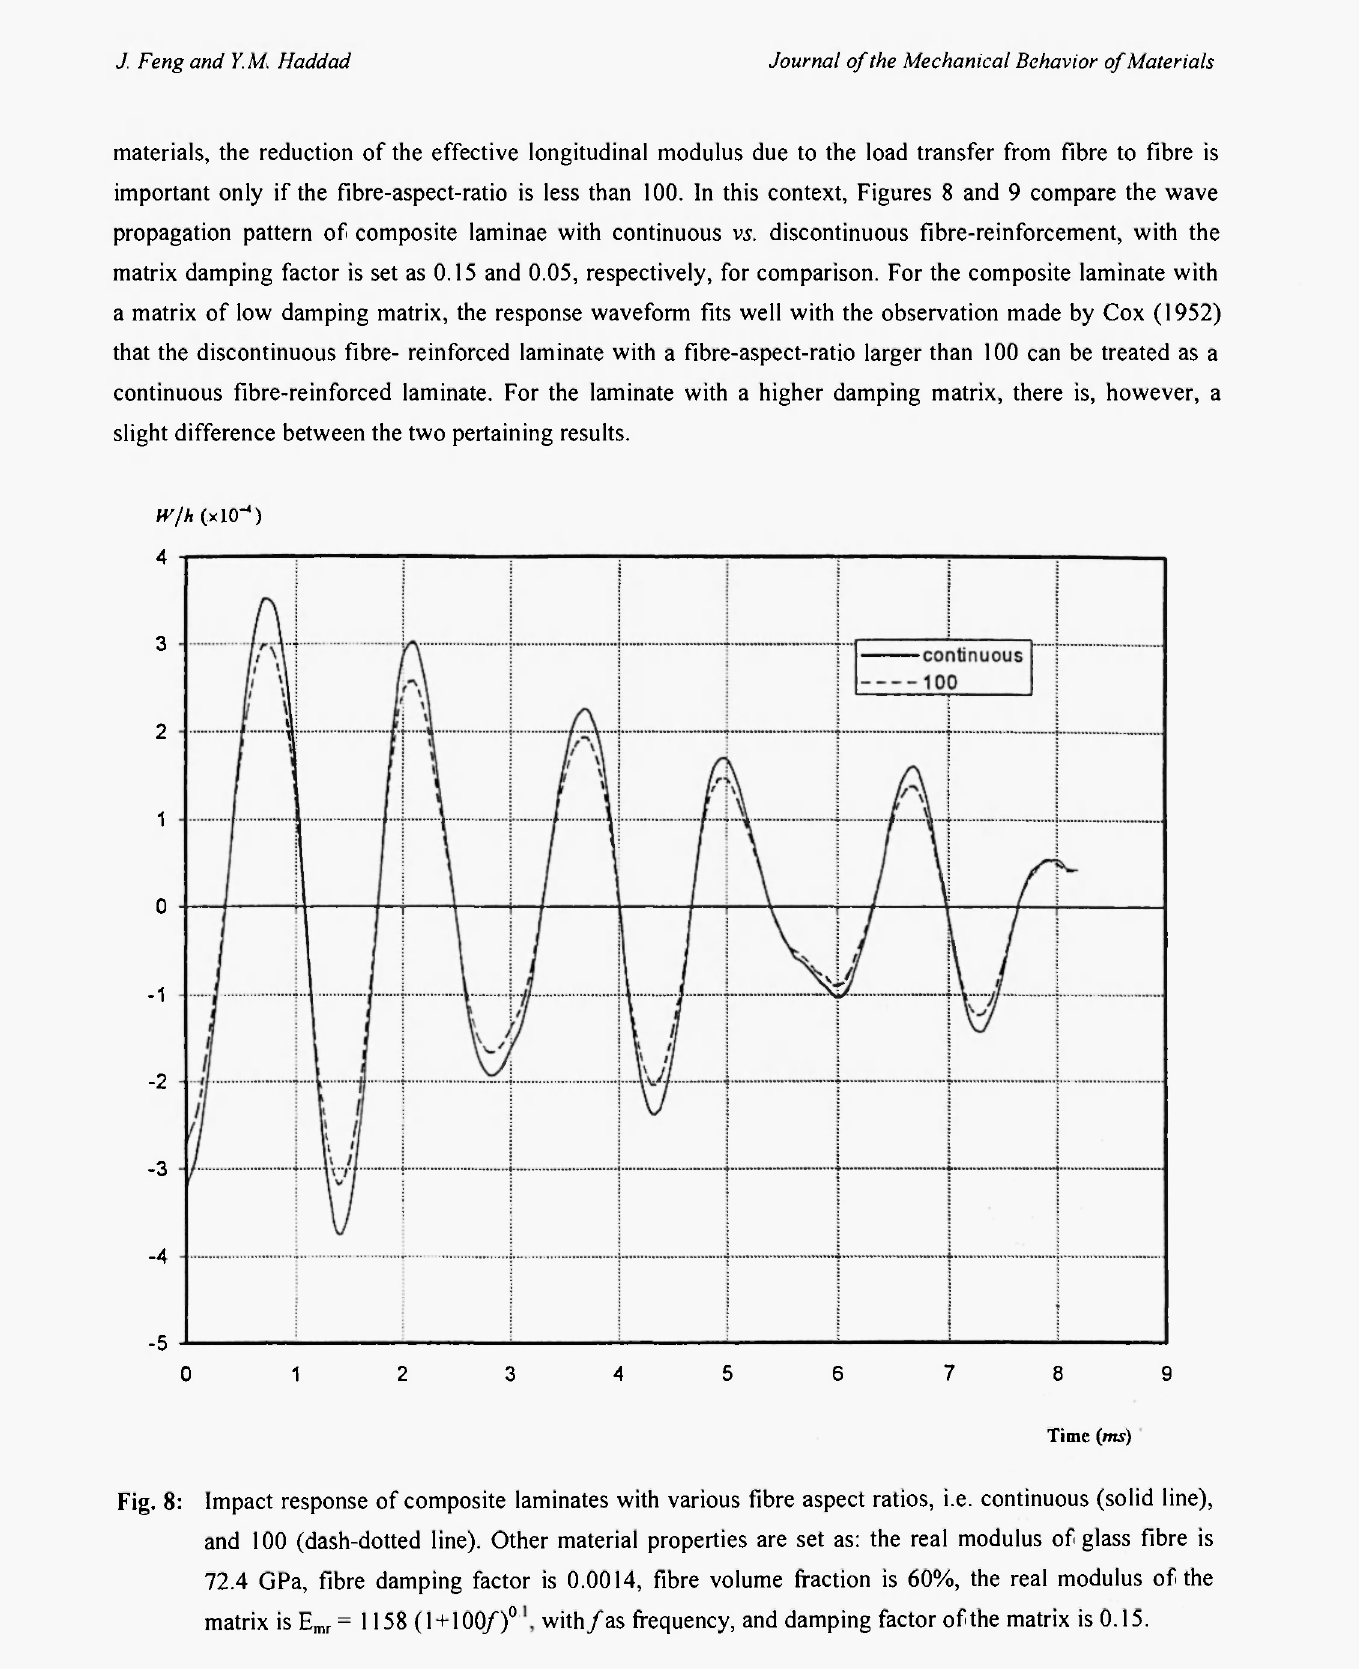
Fig. 8: Impact response of composite laminates with various fibre aspect ratios, i.e. continuous (solid line), and 100 (dash-dotted line). Other material properties are set as: the real modulus of glass fibre is 72.4 GPa, fibre damping factor is 0.0014, fibre volume fraction is 60%, the real modulus of the matrix is E mr = 1158 ( 1 + 1 0 0 / ) ° w i t h / as frequency, and damping factor of the matrix is 0.15.